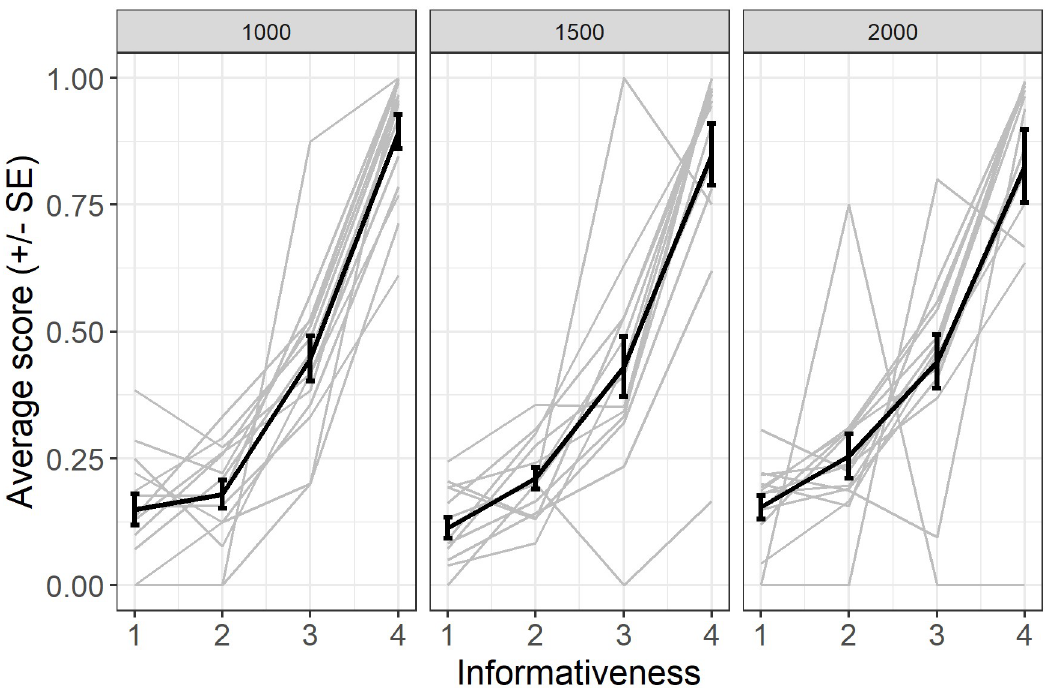
Fig 3. Average score (rewarded responses) for anticipated trials. Individual responses (light grey) with group average (error bars represent standard